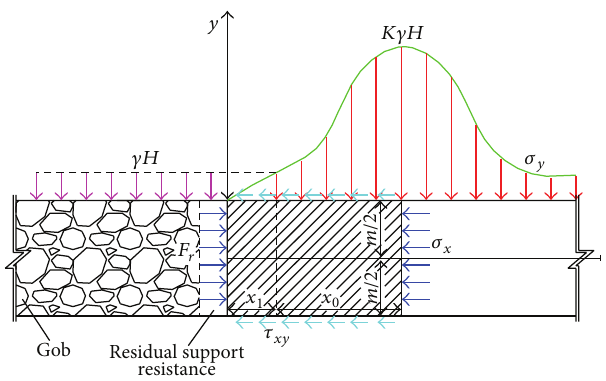
Figure 13: Mechanical model for the analysis of the stress around the gob.